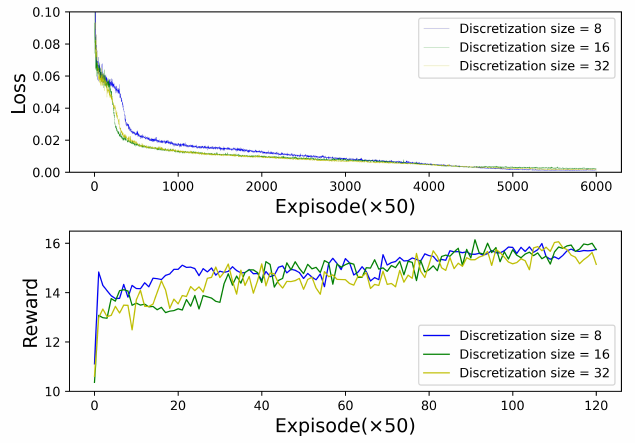
Figure 8. Evolution of loss and reward in the training process with different discretization